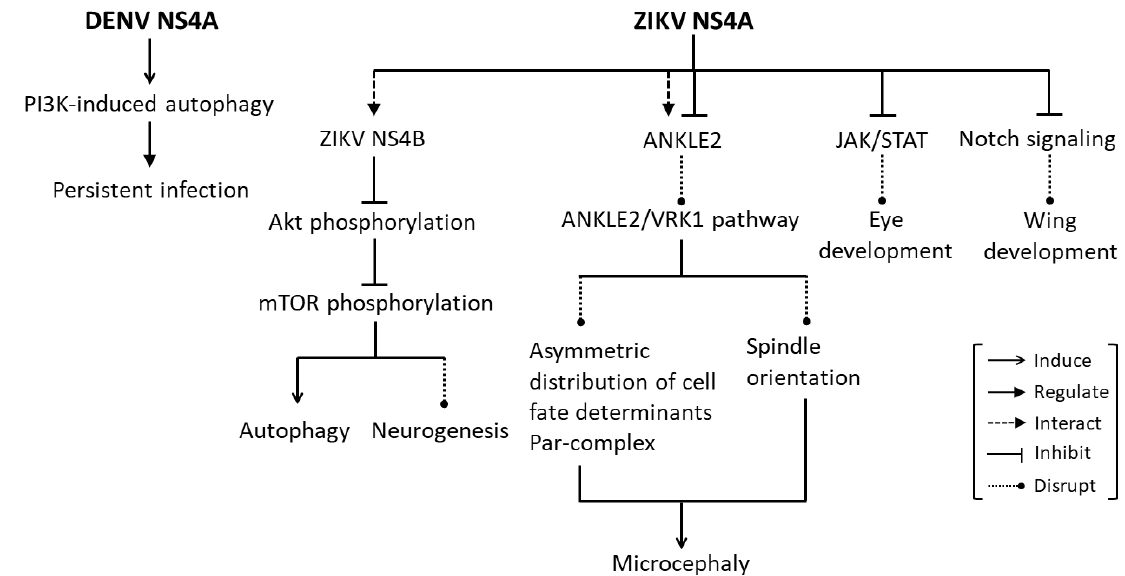
Figure 4. NS4As modulate developmental processes. NS4As modulate autophagy to facilitate persistent infection and manipulate a number of signaling pathways, i.e., Akt-mTOR, ANKLE2/VRK1, JAK/STAT and Notch signaling resulting in developmental defects.